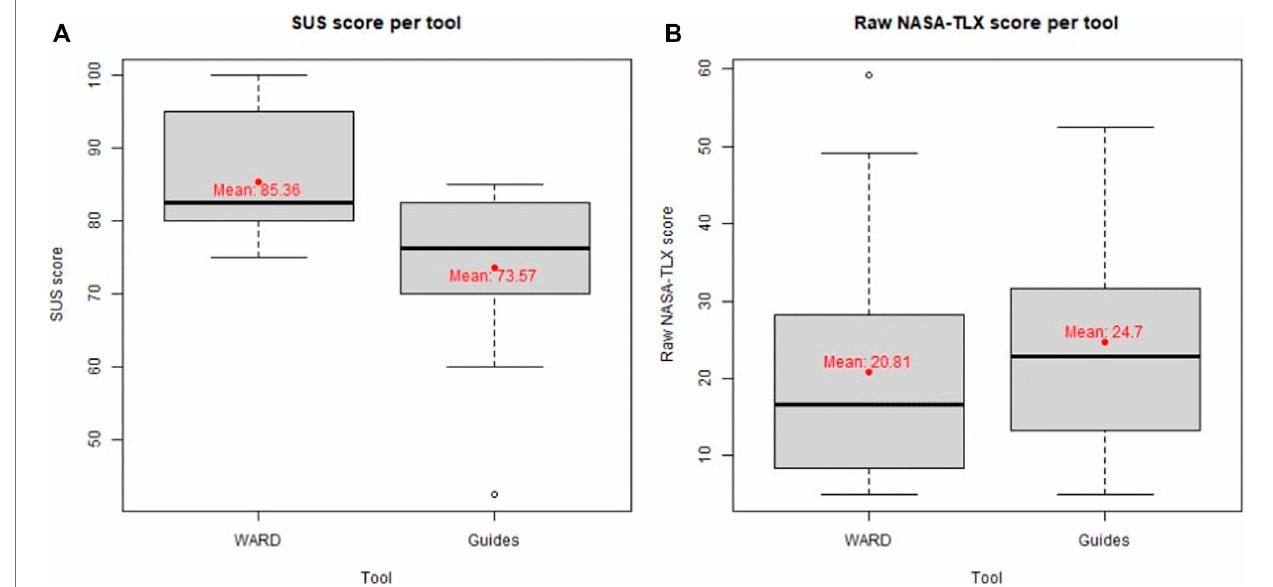
FIGURE10| InteractionwithaDigitalTwininMicrosoftGuidesusing the raycast.